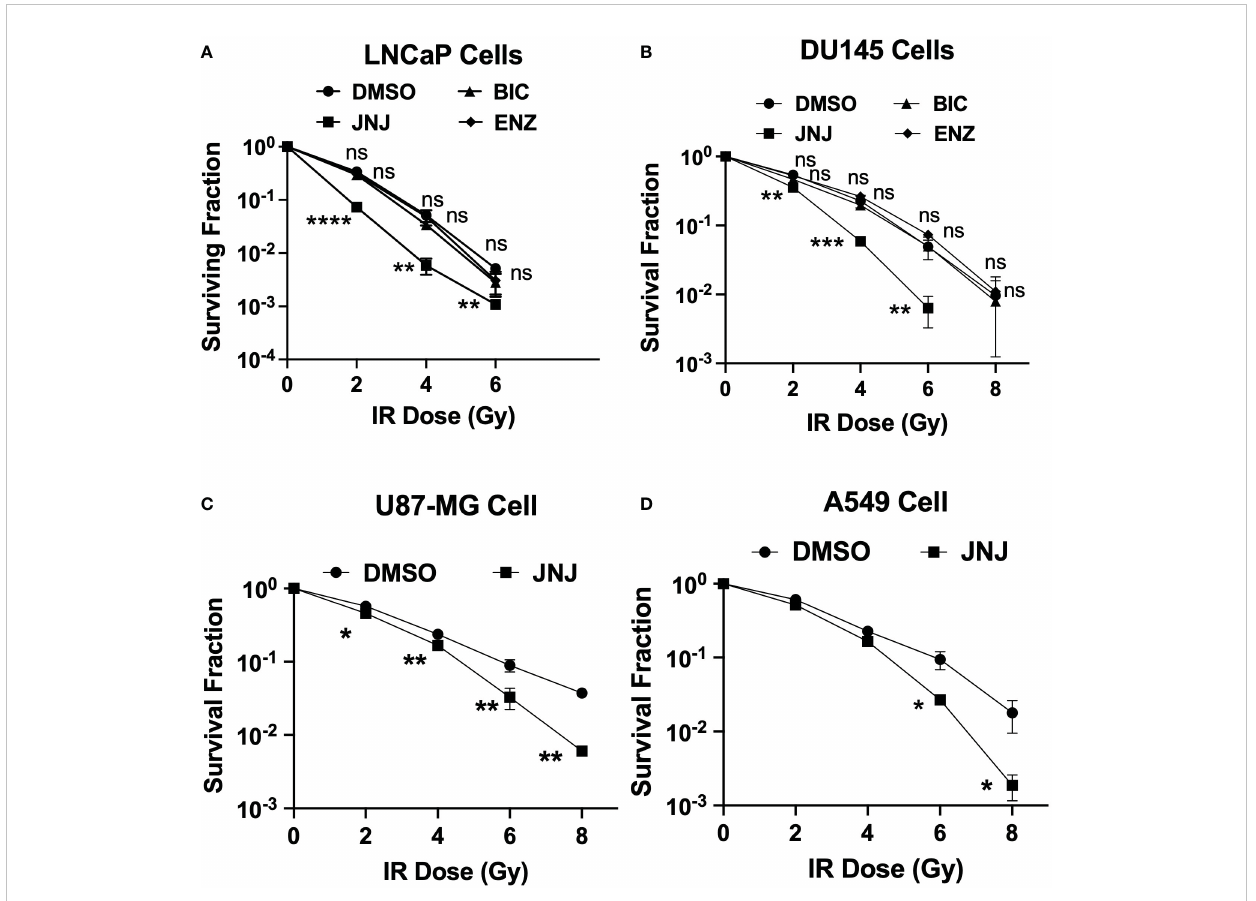
FIGURE 5 JNJ-64619178 radiosensitizes prostate and other cancer independent of AR. Surviving fraction quanti fi cation by Clonogenic assay in JNJ-64619178 treated cells immediately after indicated doses of IR treatment. (A) LNCaP Cells, (B) DU145 cells, (C) A549 cells, (D) U87-MG Cells. For statistical analysis one-way ANOVA was performed with the Tukey test for multiple analysis, each point in (A-D) are mean of SD of n=3 independent experiments (*P ≤ 0.05; **P ≤ 0.01; ***P ≤ 0.001; ****P ≤ 0.0001; NS, P >